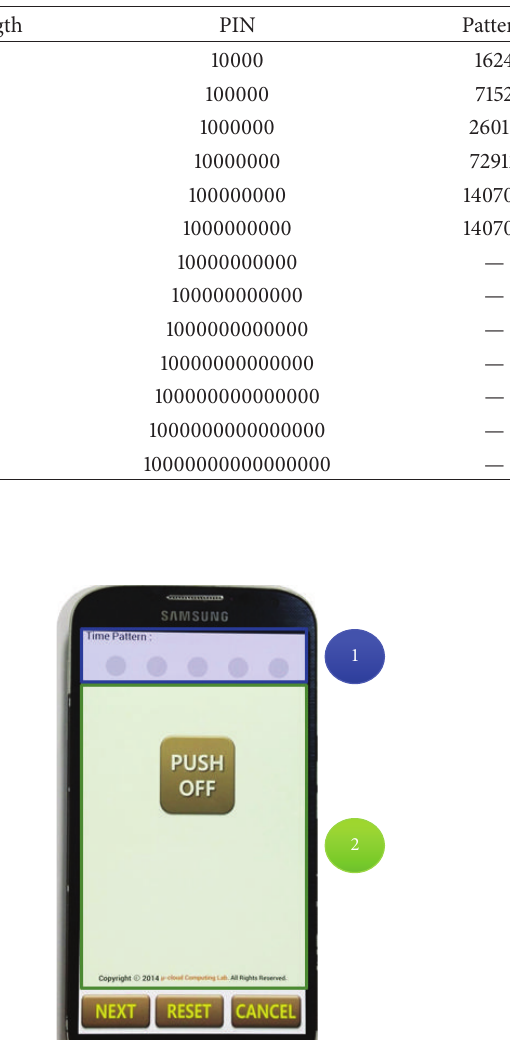
Table 2: The number of locking patterns according to the key length.